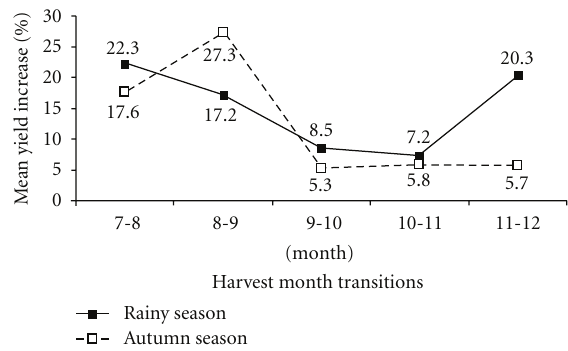
Figure 2: Percent increase in rhizome yield (kg ha − 1 ) at di ff erent harvest transitions, calculated based on the mean value of individual cropping seasons (rainy and